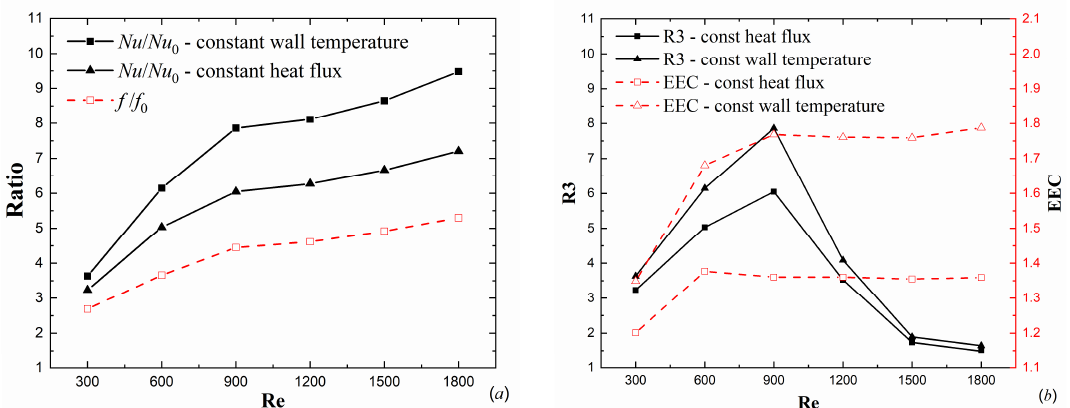
Figure 11. Thermal hydraulic performance with different boundary condition: ( a ) The enhanced ratios Nu / Nu 0 and f / f 0 ; ( b ) The evaluation criteria R3 and EEC.